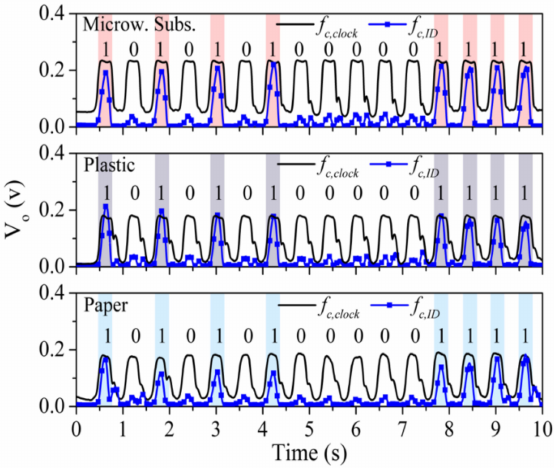
Figure 22. Envelope functions (clock and ID signals) inferred by reading the fabricated encoders in microwave substrate, in plastic substrate and in ordinary paper. Reprinted with permission from